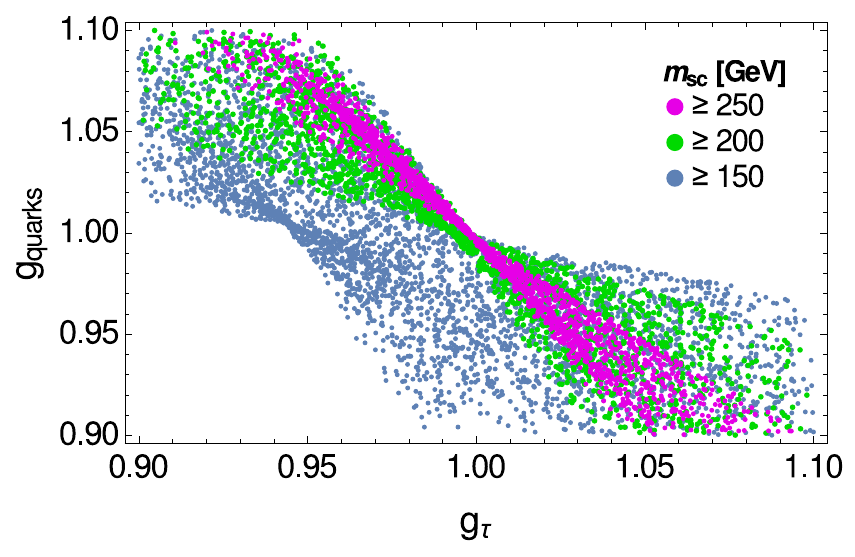
Figure 6 . Scatter plot of g quarks versus g τ . The notation for the colours of the points is the same as in figure 4.